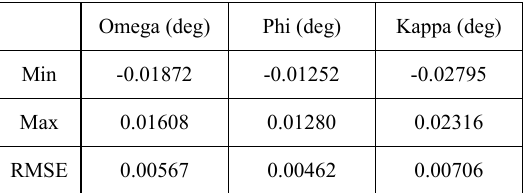
Figure 7. Graphic of Position parameter gaps